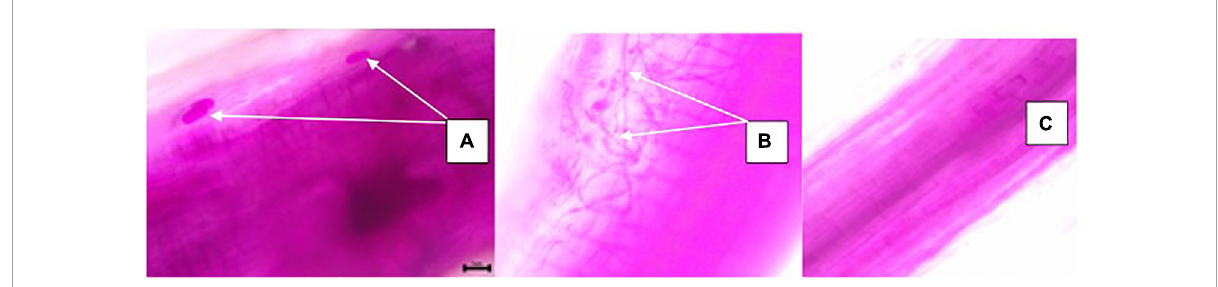
FIGURE2 Microscopic identification of mycorrhiza structures in soybean roots; Vesicles (A) , Hyphae (B) , and un-infected roots (C) as influenced by inoculation of plant growth-promoting bacteria (PGPB) and arbuscular mycorrhiza fungi (AMF), with or without the addition of nitrogen (N), phosphorus (P), and potassium (K)